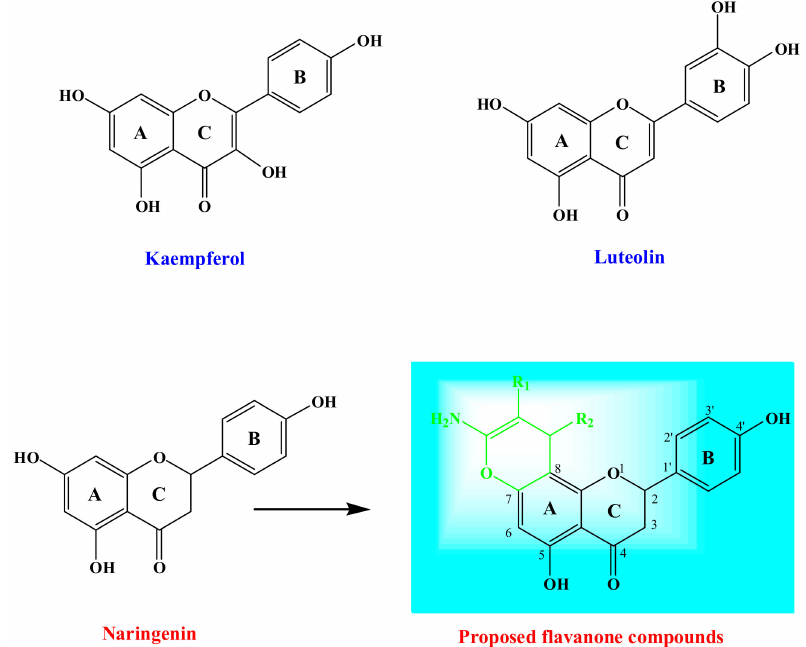
Figure 1. The design of a novel flavanone linked to chromene